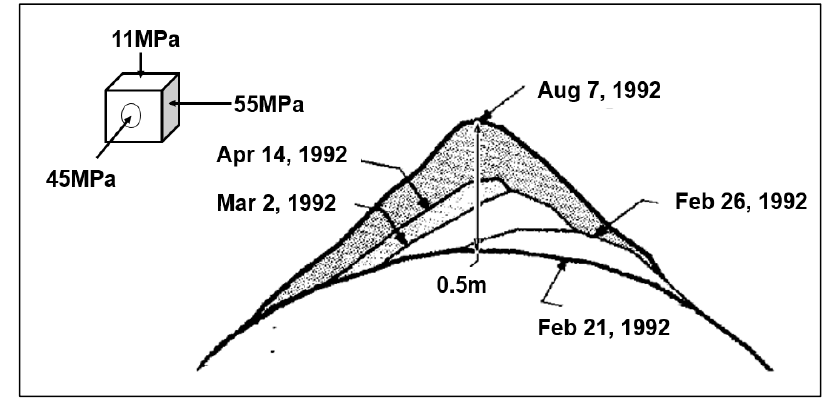
Figure 15. Observed yield profile development within the AECL URL from